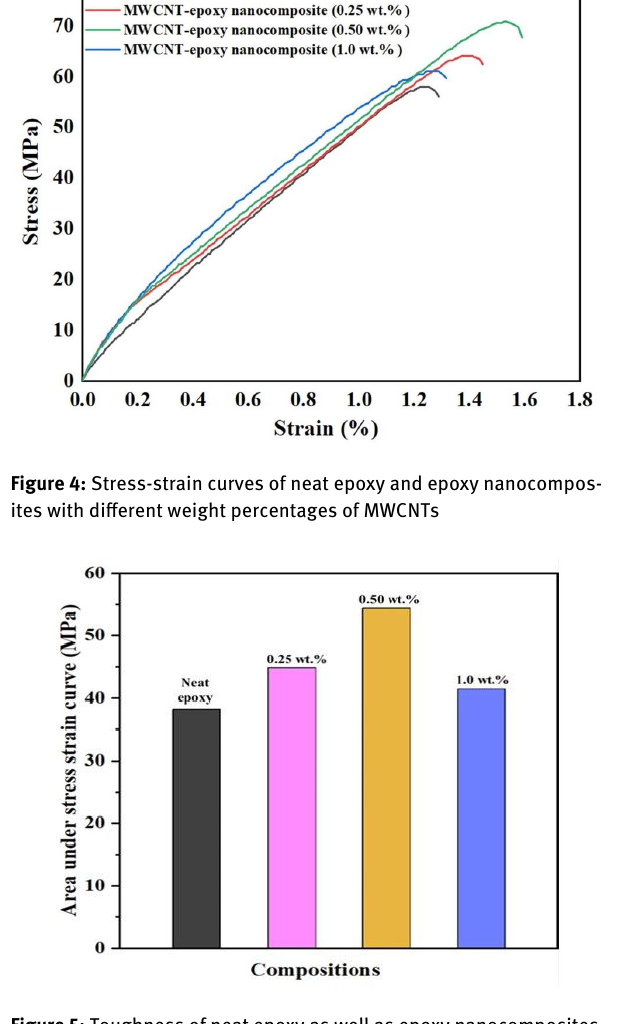
Figure 5: Toughness of neat epoxy as well as epoxy nanocomposites with different weight percentages of